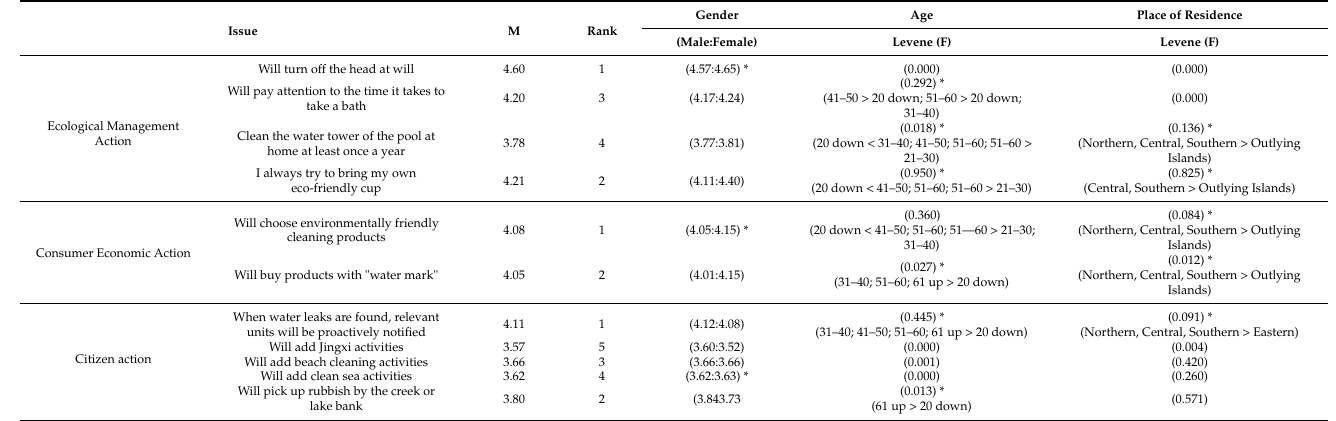
Table 4. Water use behavior analysis of the Taiwanese